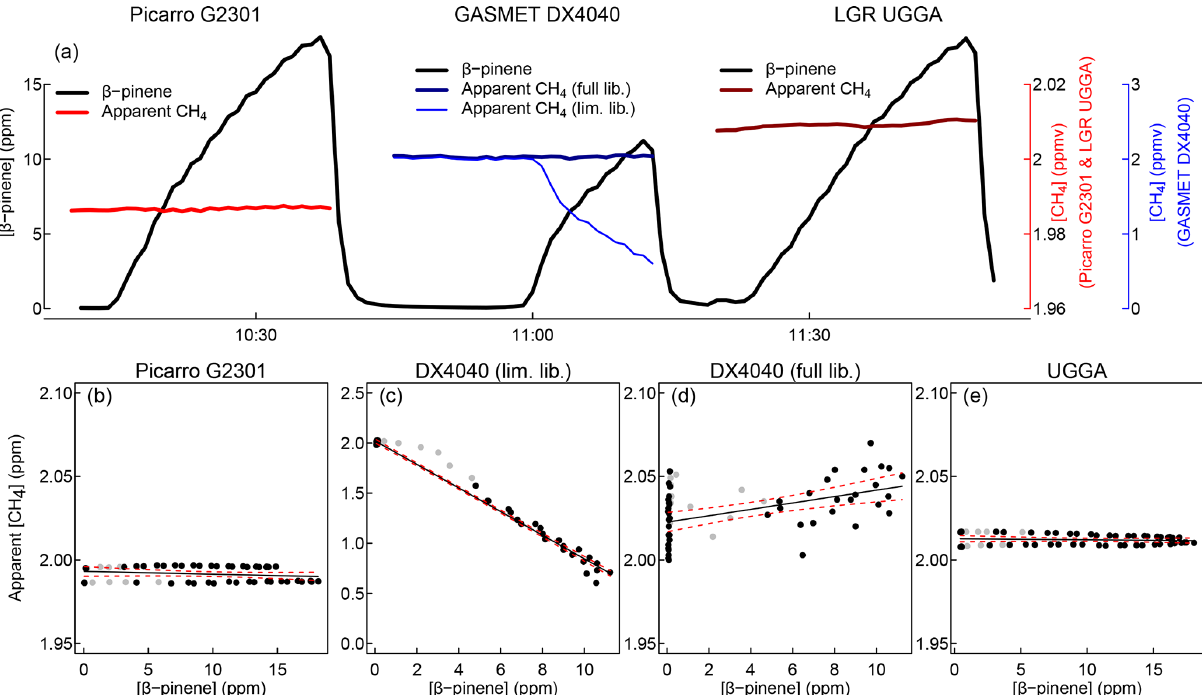
Figure 4. Quantitative measurements of the effect of β -pinene mixing ratios on measured (apparent) methane mixing ratios when analysers were challenged with a gradual increase in the β -pinene mixing ratio. The figure depicts an example of the time course of β -pinene and apparent CH 4 mixing ratios (a) as well as the relationship between β -pinene and the measured CH 4 mixing ratio (b–e) . Note that in (a) , CH 4 concentrations measured by the Gasmet DX4040 analyser are depicted on a different scale (blue) than those measured by the Picarro G2301 and LGR UGGA analysers (red). Black lines in panels (b) – (e) indicate linear regressions, dashed red lines the 95% confidence interval of these regressions. Data points that occurred after rapid changes in the β -pinene mixing ratio and that were therefore excluded from the regression analysis are depicted in